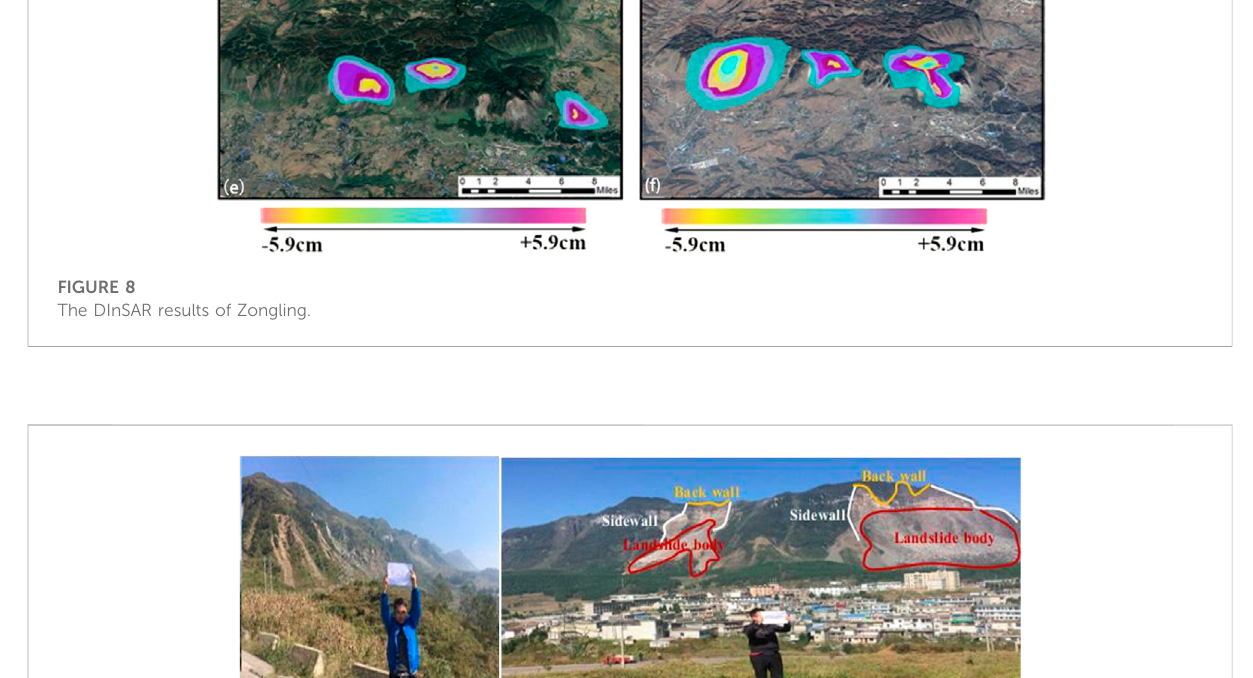
FIGURE 9 Field visit photographs of the landslide in the town of